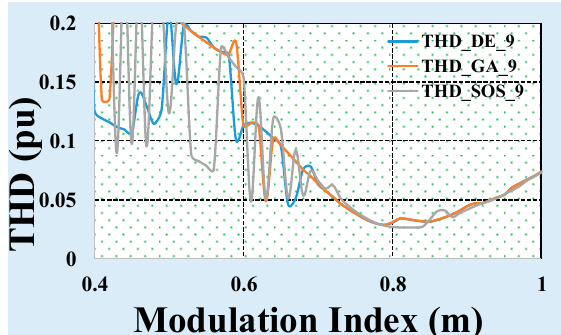
Figure 9. Zoomed view.